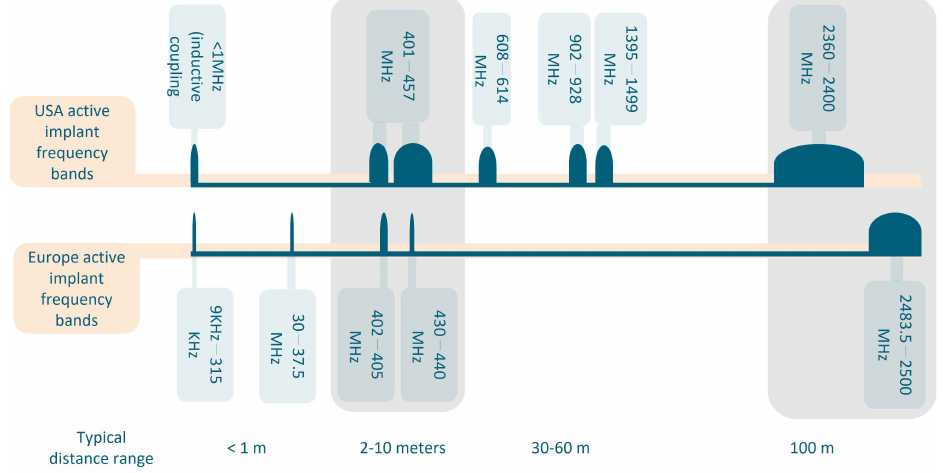
Figure 1. Frequency bands allocated to medical devices: an overview of the USA and European regulations, and the typical distance of these frequency bands. Common frequencies to both USA and European regulations are highlighted in